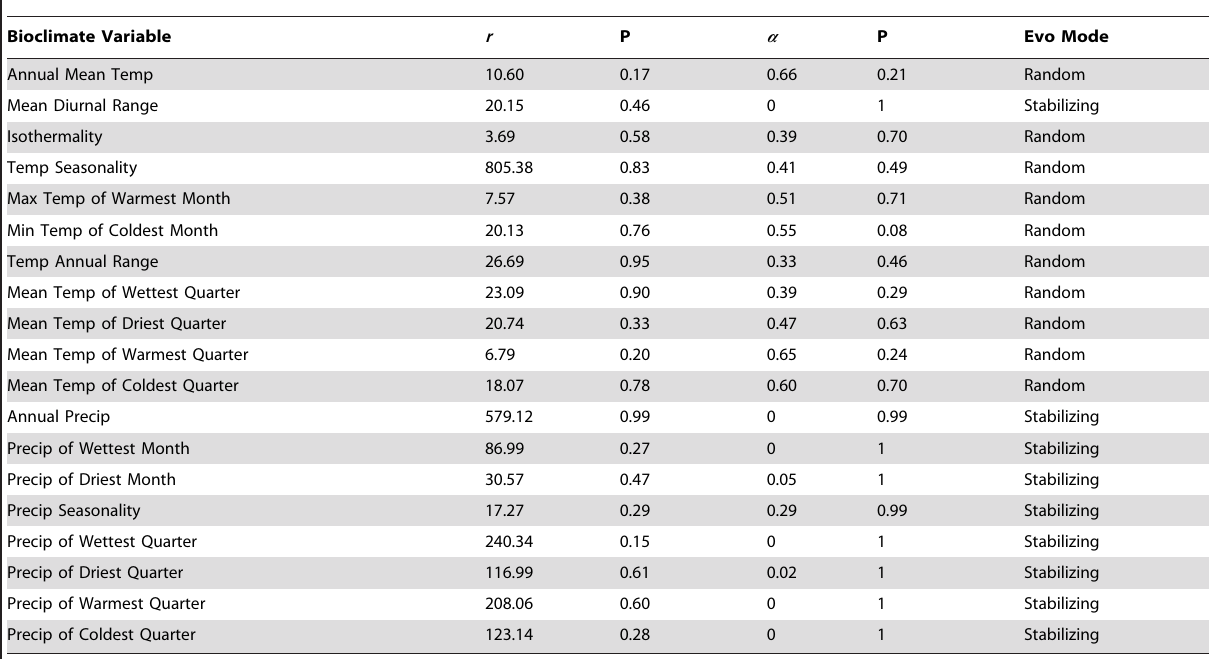
Table 2. Maximum likelihood estimate of evolutionary rate and mode.